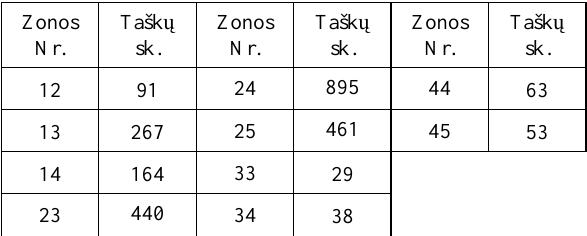
Metodai, panaudoti SRM sudaryti ir tikslumui tirti: